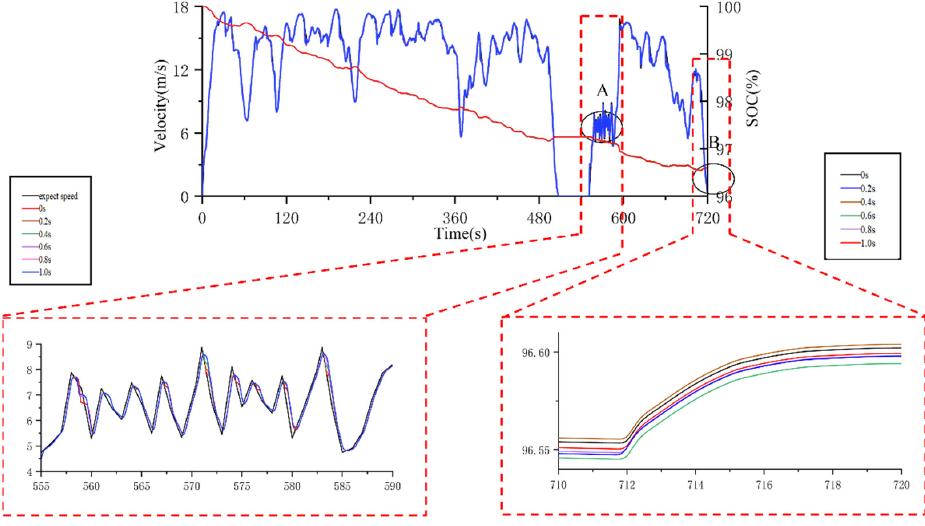
Figure 8. Speed values and SOC with different delay times under real operating conditions.